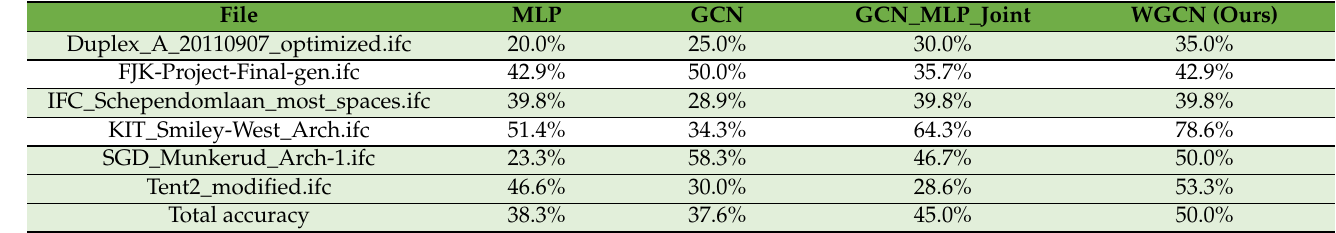
Table 1. Inductive Inference evaluation of the Neural Network models: MLP = simple multi-layer pre- ceptor neural network, GCN: Graph convolutional network of Kipf and Welling [11]. GCN_MLP_joint mixture of MLP and GCN classifier, WGCN = novel Weighted Graph Neural Network Model.